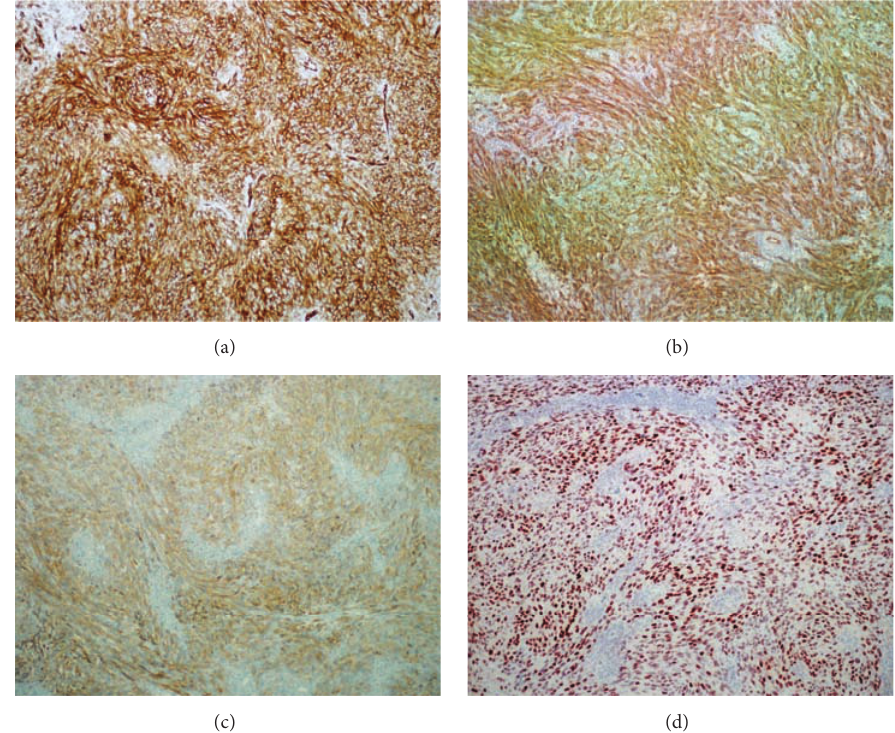
Figure 3: Diffuse positive staining of tumor cells immunohistochemically with (a) CD31, (b) CD34, (c) D2-40, and (d) HHV8 ( × 100).